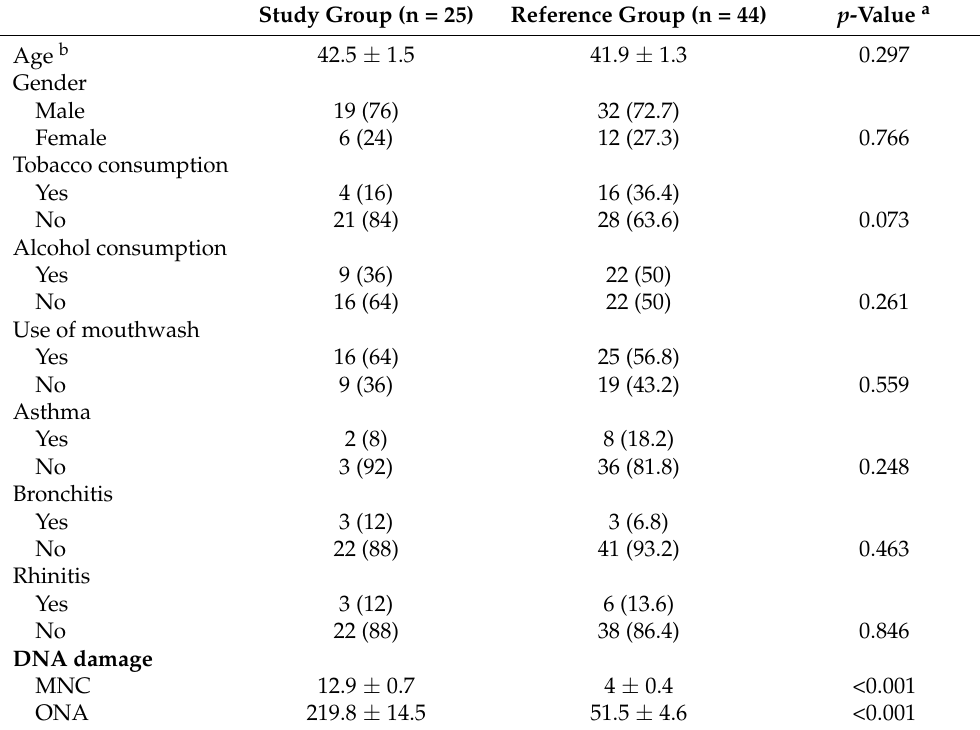
Table 1. Description of the demographic characteristics, lifestyle habits, and health status of the studied population groups (mean ± standard error—for continuous variables or % for categorical